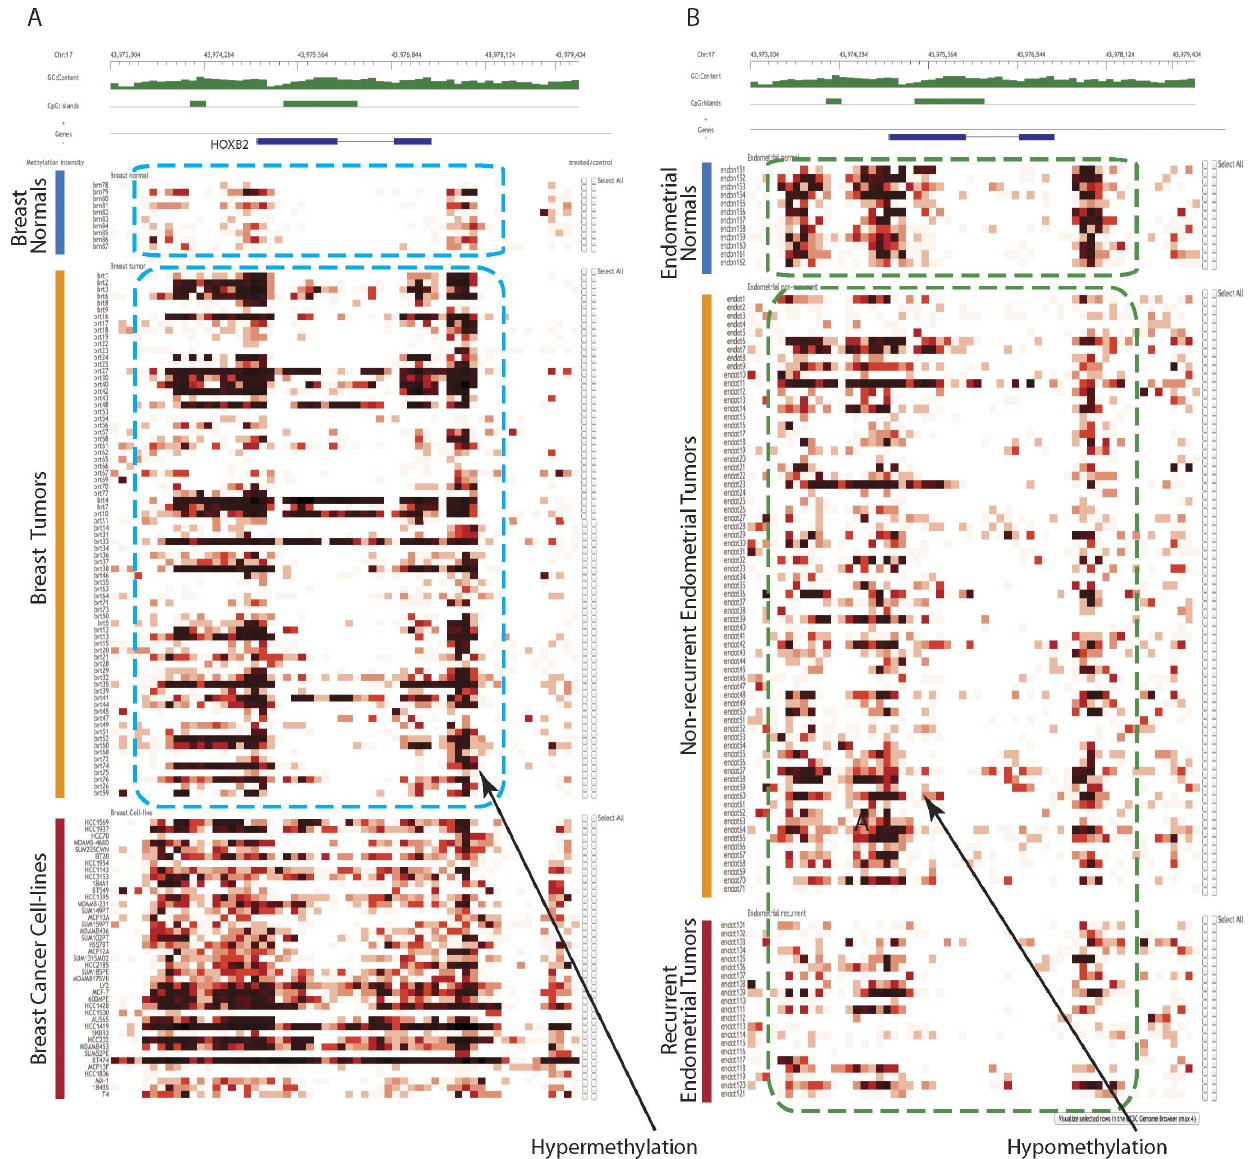
Figure 3. Discovery of tumor specific methylation profiles. HOXB2 was hypermethylated in breast tumors compared with breast normal (A), while hypomethylated in endometrial cancer tumors compared with endometrial normal